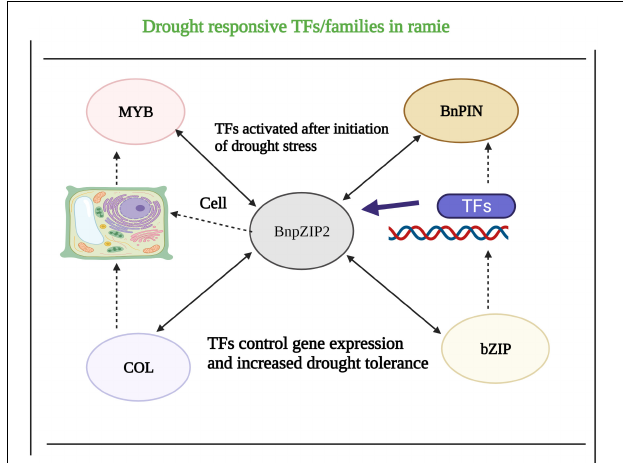
FIGURE 6 | Role of different TFs in ramie crop under severe drought stress (DS). TFs have a key role in drought tolerance. MYB, COL, bZIP, and BnPIN showed enhance tolerance to DS. These TFs regulate gene expression and enable plant to withstand with drought episodes.